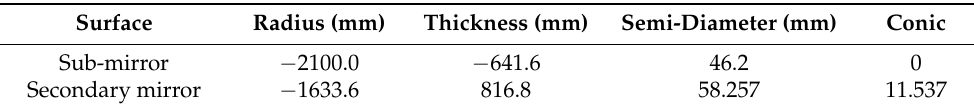
Figure 4. The initial configuration of the Golay3 MMT. Table 2. The parameters of the initial configuration of the Golay3 MMT.